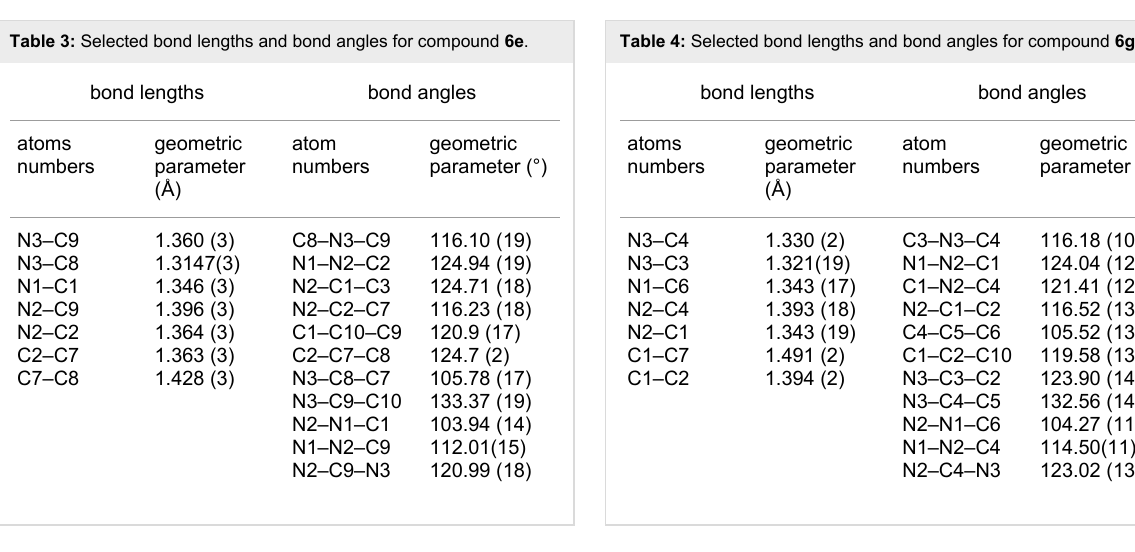
Figure 3: ORTEP diagram of compound 6e .